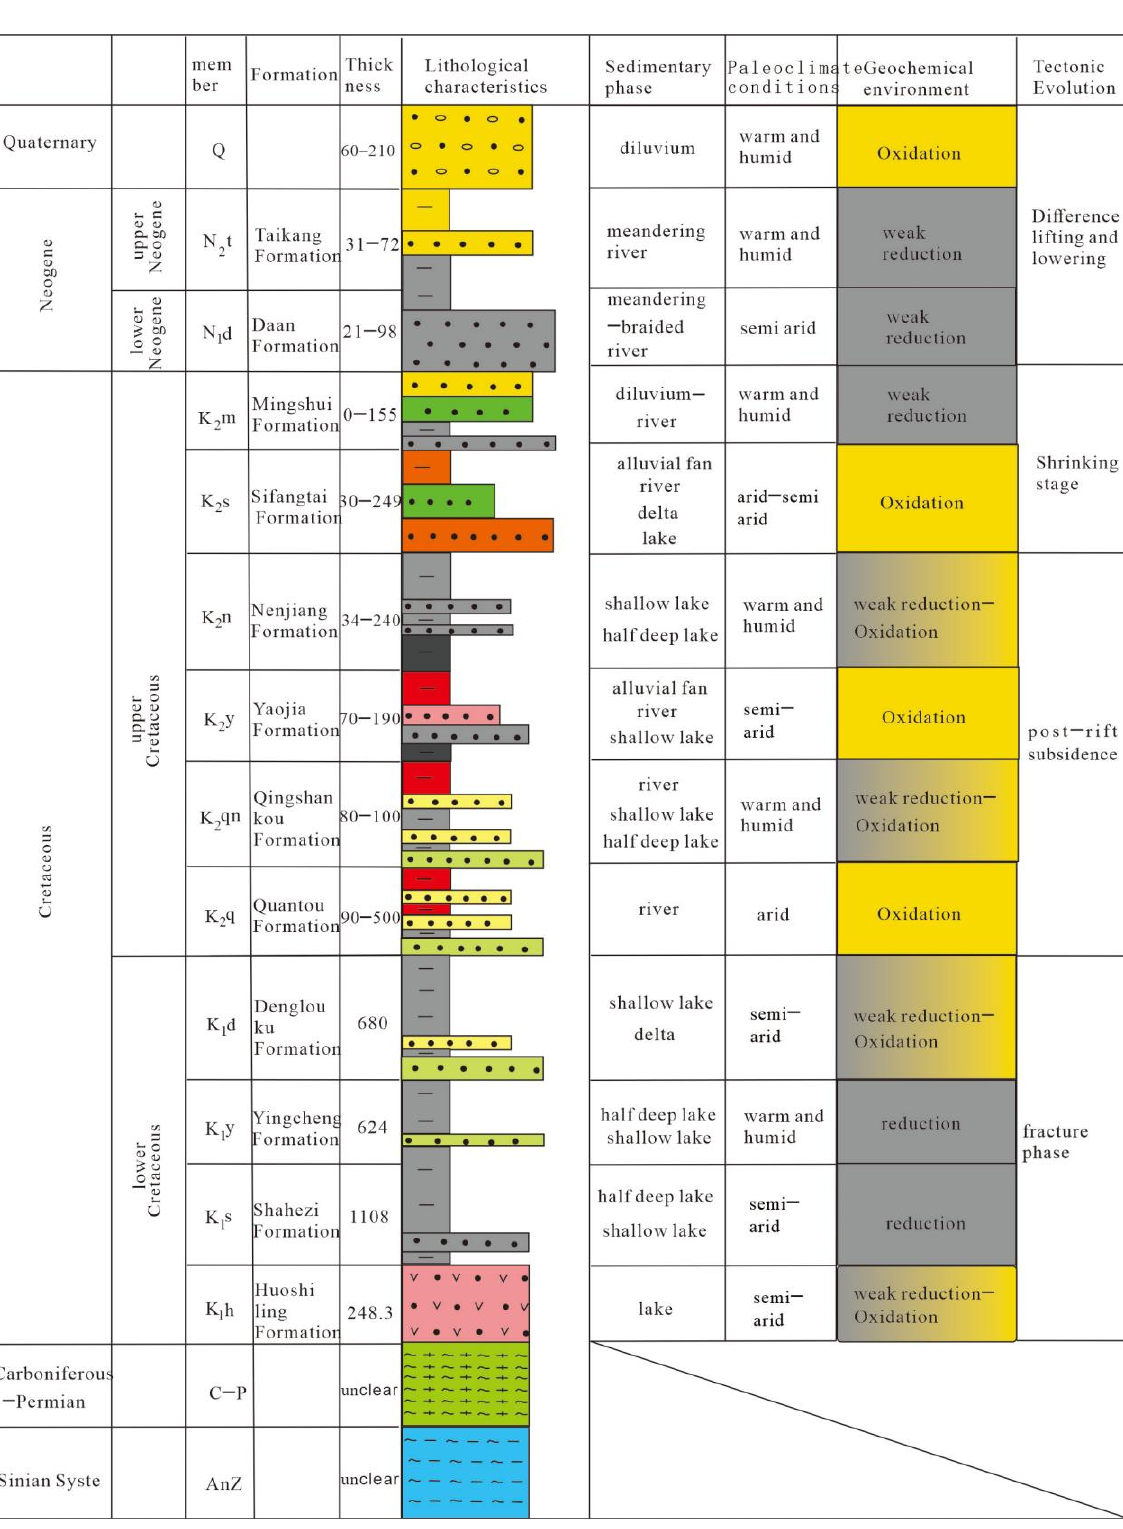
Figure 2. Stratigraphic sketch of the northern part of Songliao Basin.